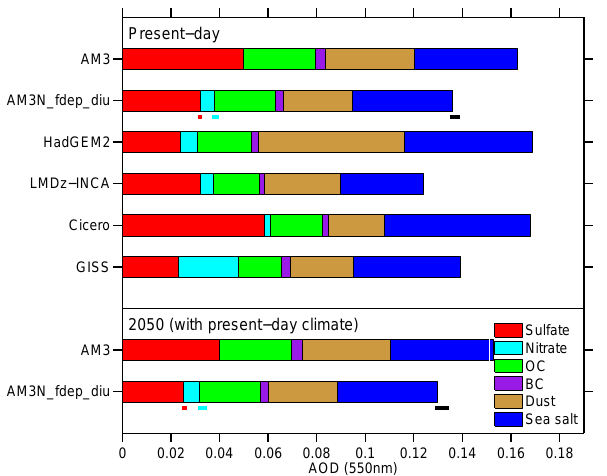
Figure 10. Annual mean NO − optical depth at 550nm in AM3N 3 (top left panel) and its relative sensitivity to the treatment of NH 3 emissions, NO − production, and loss in % for 2008–2010 condi- 3 tions. The change in NO − optical depth relative to AM3N is in- 3 dicated in the bottom left for each configuration. The sensitivity is only shown in regions where NO − optical depth is greater than 3